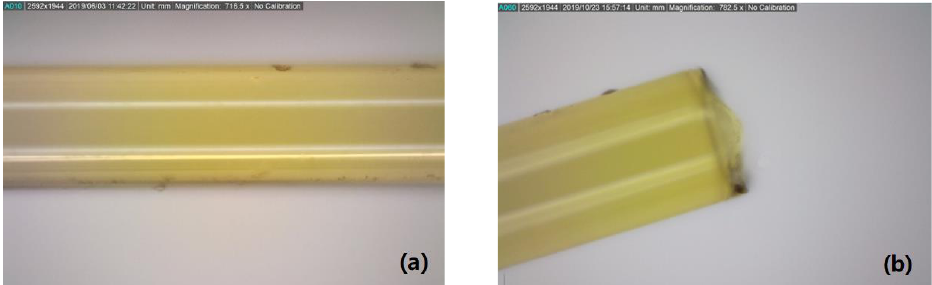
Figure 4. Representative microscope images at 716.5× magnification in the region of the sensor for a Type II trans-jacket FBG: ( a ) microscope image of the optical fibre at the grating, and ( b ) image of the failure location post-fatigue test.